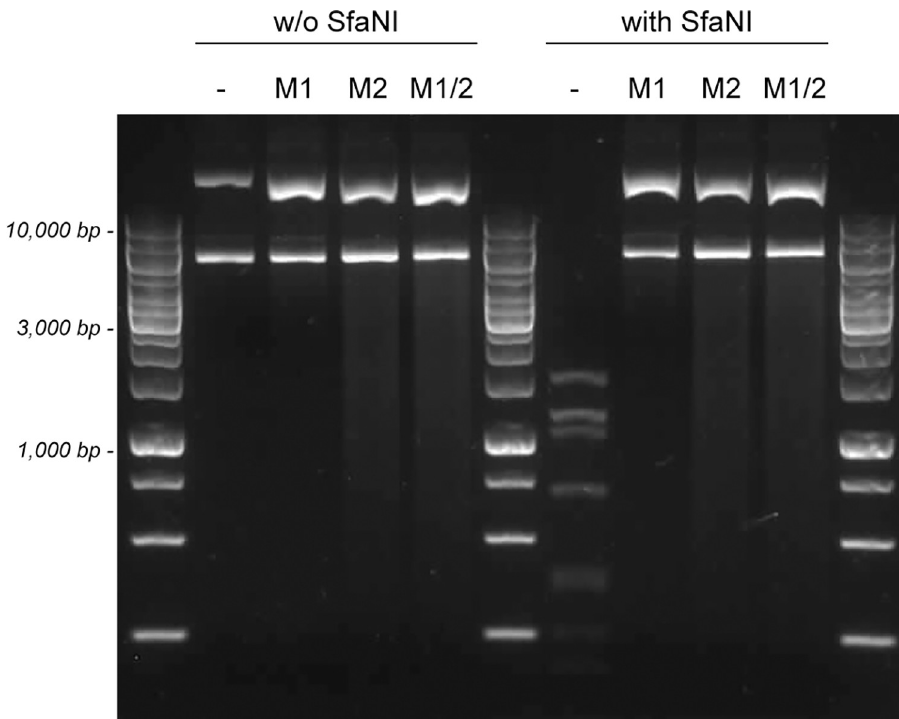
Fig 6. Digestion of methylated and unmethylated pUC19-P slp -pyrE plasmid DNA with the restriction endonuclease SfaNI. Restriction digests were performed by incubating unmethylated plasmid DNA (-) as well as plasmid DNA methylated with either M1.Cal02329 (M1), or M2.Cal02329 (M2), or both M1.Cal02329 and M2. Cal02329 (M1/2) in the presence of the restriction endonuclease SfaNI. A restriction digest without SfaNI was included as